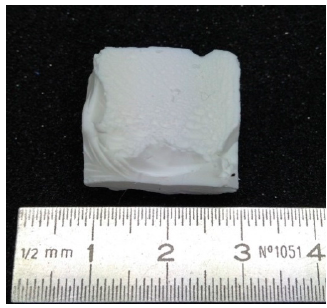
Figure 3. Low-flexible silica aerogel SA2.